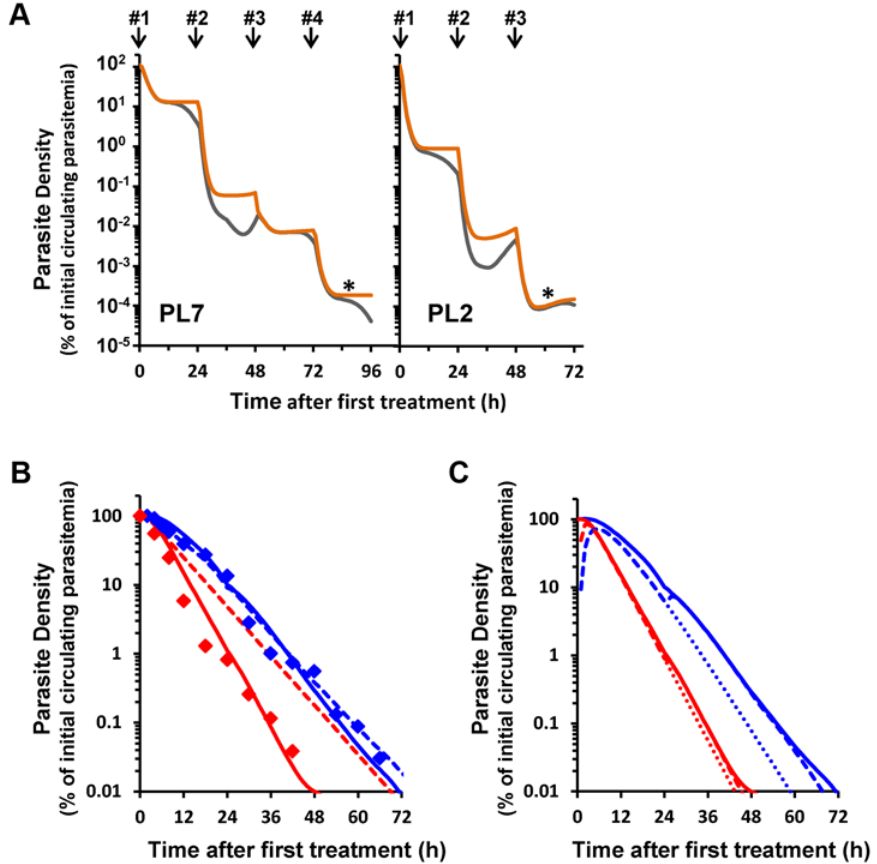
Fig 7. Delayed parasite clearance of resistant strains reflects both reduced killing and delayed removal of unviable parasites. (A) Viable parasite load during DHA treatment regimen. The number of total (circulating and sequestered; orange curves) and circulating (grey curves) viable parasites during DHA therapy in hypothetical patients presenting with ring-stage PL7- and PL2-like infections were simulated using CED model parameters and an in vivo DHA pharmacokinetic profile (see S1 Appendix, S3 Table). Arrows indicate the times of drug administration. (B) Influence of unviable parasite removal on parasite clearance profiles. The circulating unviable parasites in (A) in the PL2 and PL7-like infections (red and blue curves, respectively) were modelled to disappear from circulation with a half-life of 5 h (dashed curves) or exhibit more complex removal (solid curves) involving strain-dependent (1- and 3.5-h half-lives for PL2 and PL7), in addition to a strain-independent (3-h half-life) component. Symbols correspond to median circulating parasite loads from patients in Pailin (blue) and Wang Pha (red) [41]. (C) Contribution of unviable parasites to parasite clearance curves. The solid curves represent the simulated parasite clearance curves shown in Fig 7B incorporating the complex clearance of unviable parasites. The dashed curves correspond to the total number of unviable parasites at each time point and the dotted curves to the unviable parasites produced during the course of the first treatment (i.e., formed during the first 24